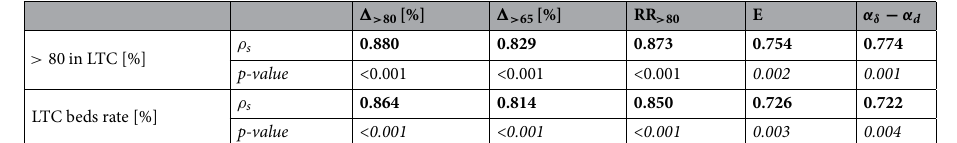
Table 7. Spearman’s correlations ( ρ s -coefficients) among dependent variables deaths increase in aged >65 ( � > 65 [%]) and aged >80 ( � > 80 [%]), Mortality Ratio Rate (RR), Excess of deaths (E), scaling exponents difference ( α δ − α e ) and LTCFs independent variables are reported. Bold value indicate the relevant results.